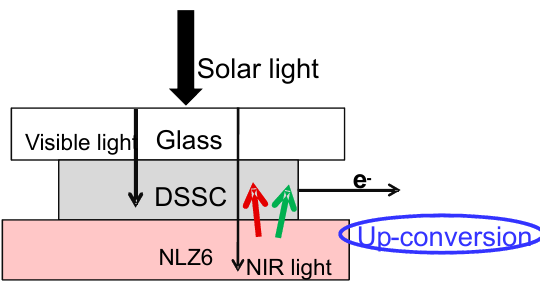
Fig. 9 Schematic illustration of NLZ6 applied in the DSSC, which can upconvert partial NIR light into red and green light, thus improving solar cell efficiency.